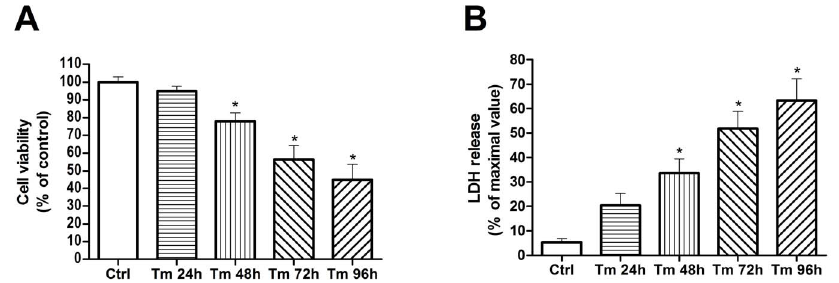
Figure 2. Cardiomyocyte viability upon tunicamycin treatment. Cardiomyocytes were treated with 100 ng/ml tunicamycin (Tm) for indicated time (0, 24 h, 48 h, 72 h, 96 h) and cell viability was measured by the MTT-assay (A) and cell injury tested by the LDH-assay (B). For cell viability, the viable cell number was compared with Control group. For the LDH release assay, all the values were compared with Control group. *P , 0.05 vs Ctrl, n=5.